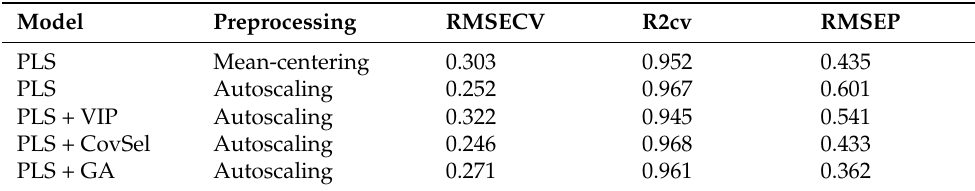
Table 3. Results of Partial Least Squares